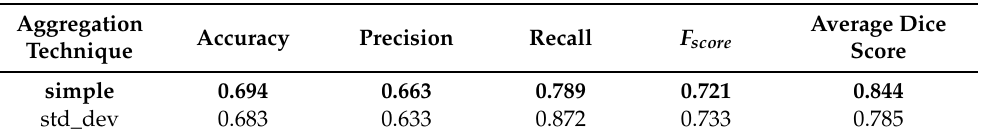
Table 5. Results of Raspberry Pi-centric federated semi-supervised learning experiments. The best performance is highlighted in bold.